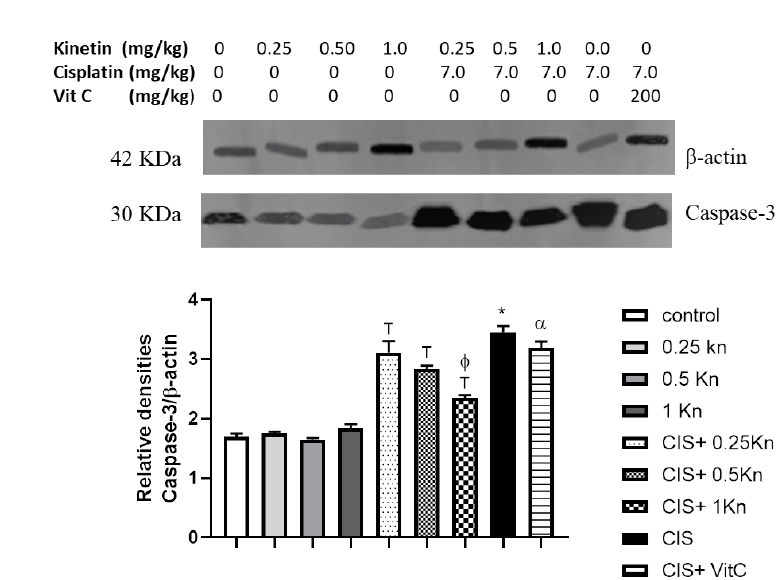
Figure 6. Representative Western blot analysis of caspase-3 protein expression of testicular tissues, showing protein bands of each group ( A ) and graphs presenting their densitometric analysis ( B ). Data are represented as mean ± SEM, *, T, ф and α are significant differences from control, 0.25 Kn, CIS, CIS+ 0.25 Kn and CIS+ 1 Kn groups, respectively, at p < 0.05 where n = 5–6. Kn, kinetin; CIS, cisplatin; VitC, vitamin